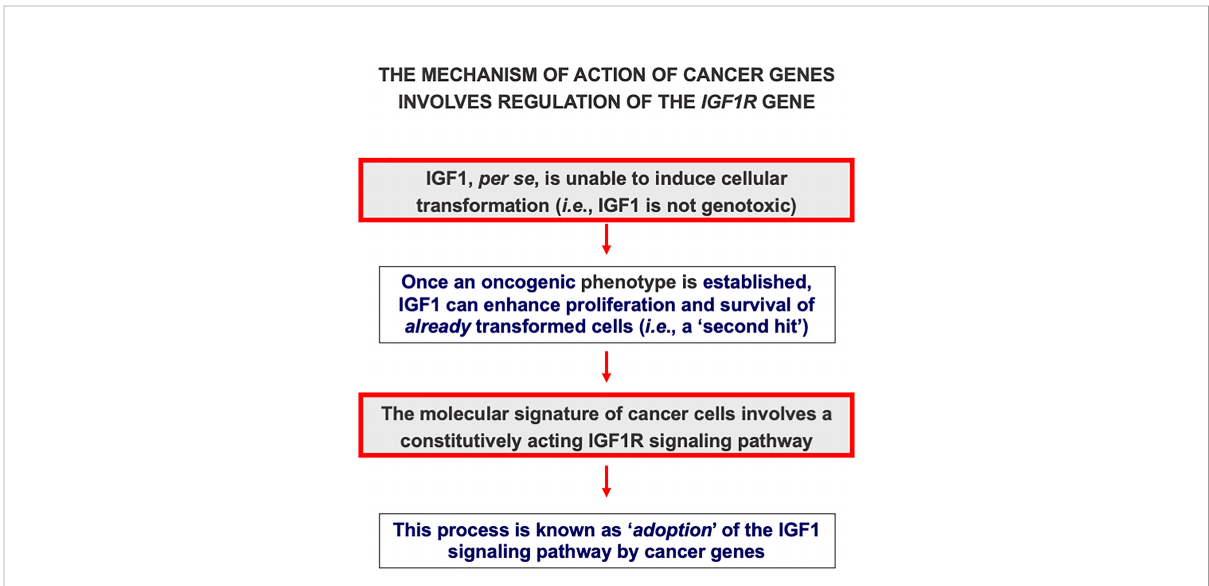
FIGURE 2 Cancer genes adopt the IGF1 signaling pathway. IGF1 is regarded as a non-genotoxic growth factor, i.e. , it is unable, in itself, to induce mutations or transformation. However, once an oncogenic event has occurred, IGF1 can enhance proliferation and survival of already transformed cells. In the context of the ‘ two hit hypothesis ’ , IGF1 action is regarded as a second, or permissive, hit. Multiple cancer genes, including oncogenes and anti-oncogenes, adopt the IGF1 signaling pathway. In agreement with this notion, cells devoid of the IGF1R usually do not undergo